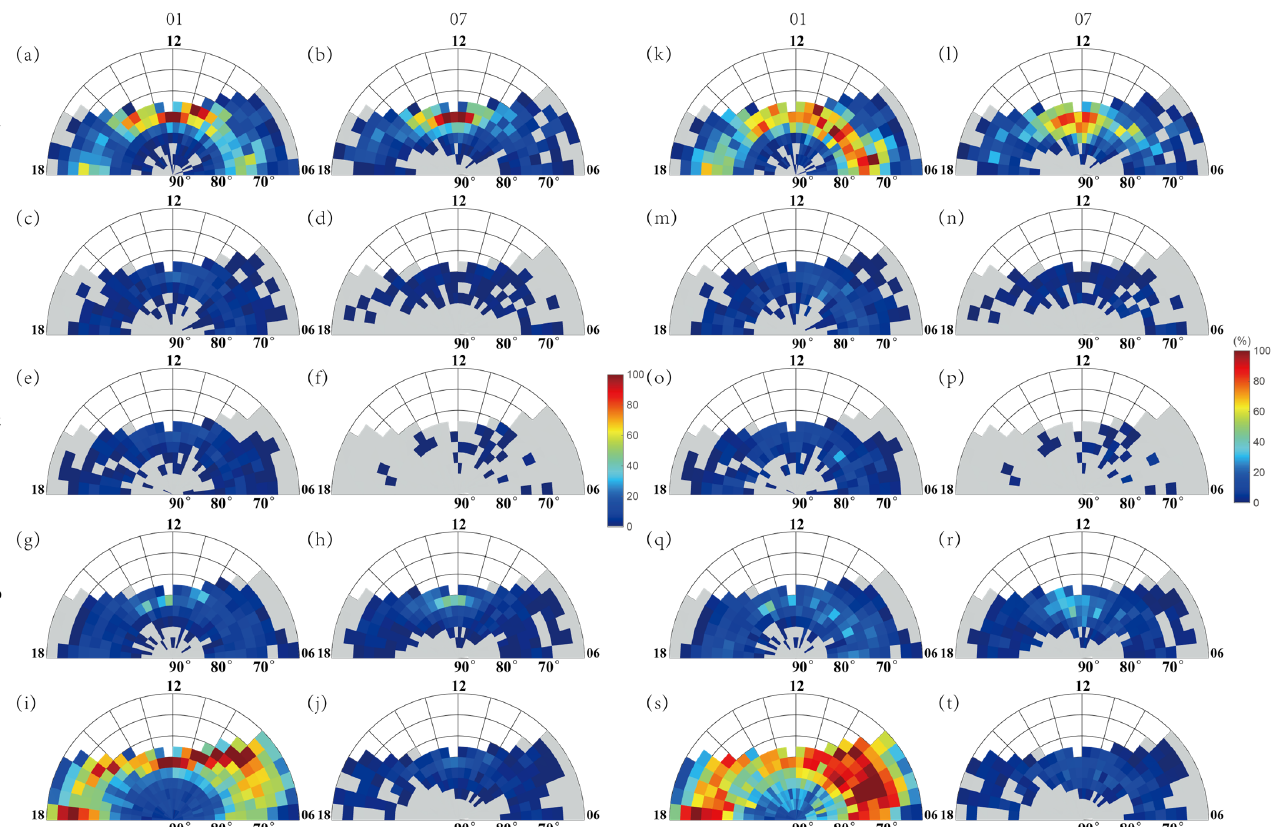
Figure 3. The distribution and occurrence for different types of ion upflows in January (left panel)/July (right panel) in MLT/MLAT coordinate. From top to bottom are ion upflows of type A to E, respectively. ( a – j ) Total events for each month and type, ( k – t ) average orbital occurrence in different month and type.